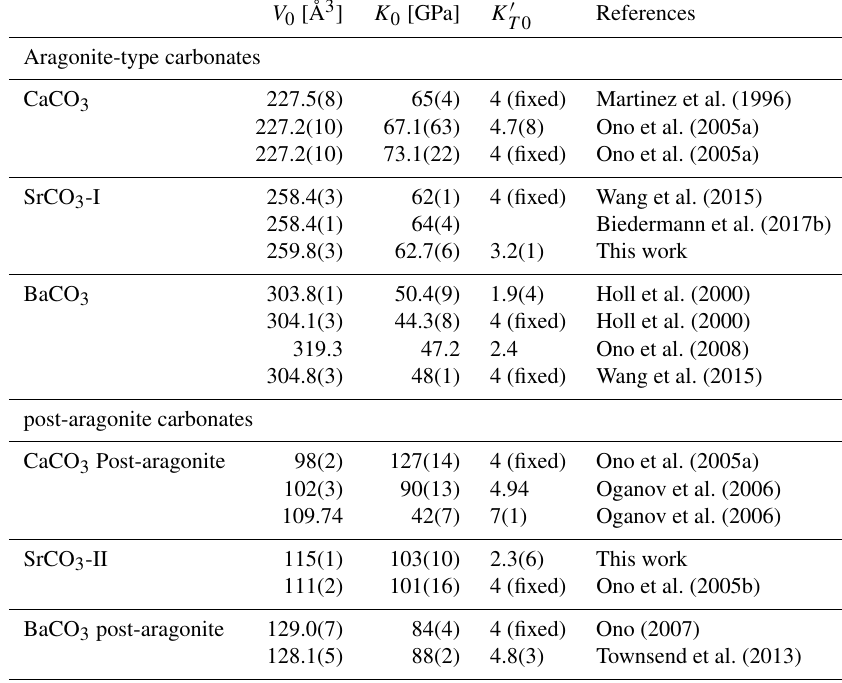
Table 4. Comparison of the literature data for aragonite-type ( Pmcn ) and post-aragonite ( Pmmn or P 2 1 2 1 2) carbonates at ambient conditions.